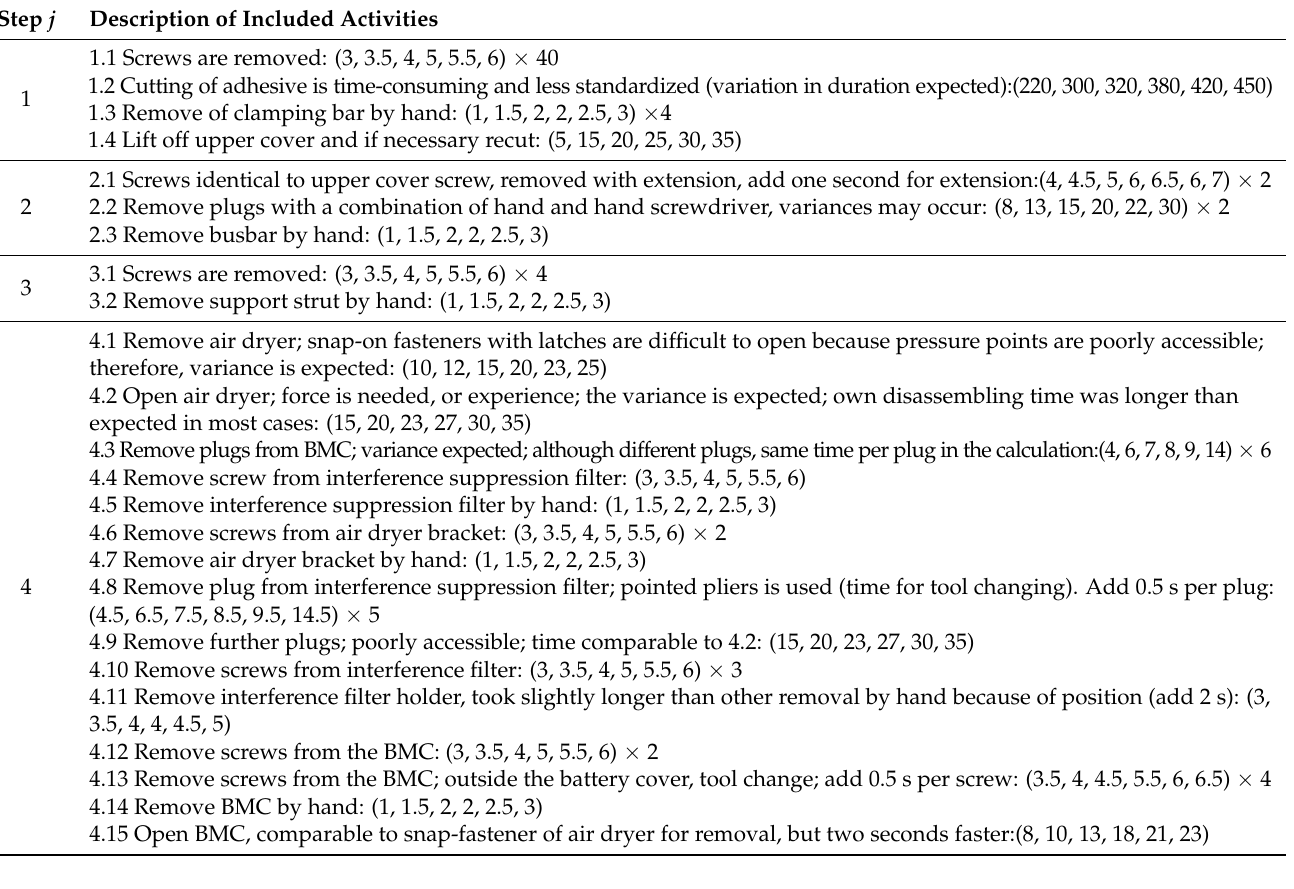
Table A1. Description of fuzzy durations on a single activity